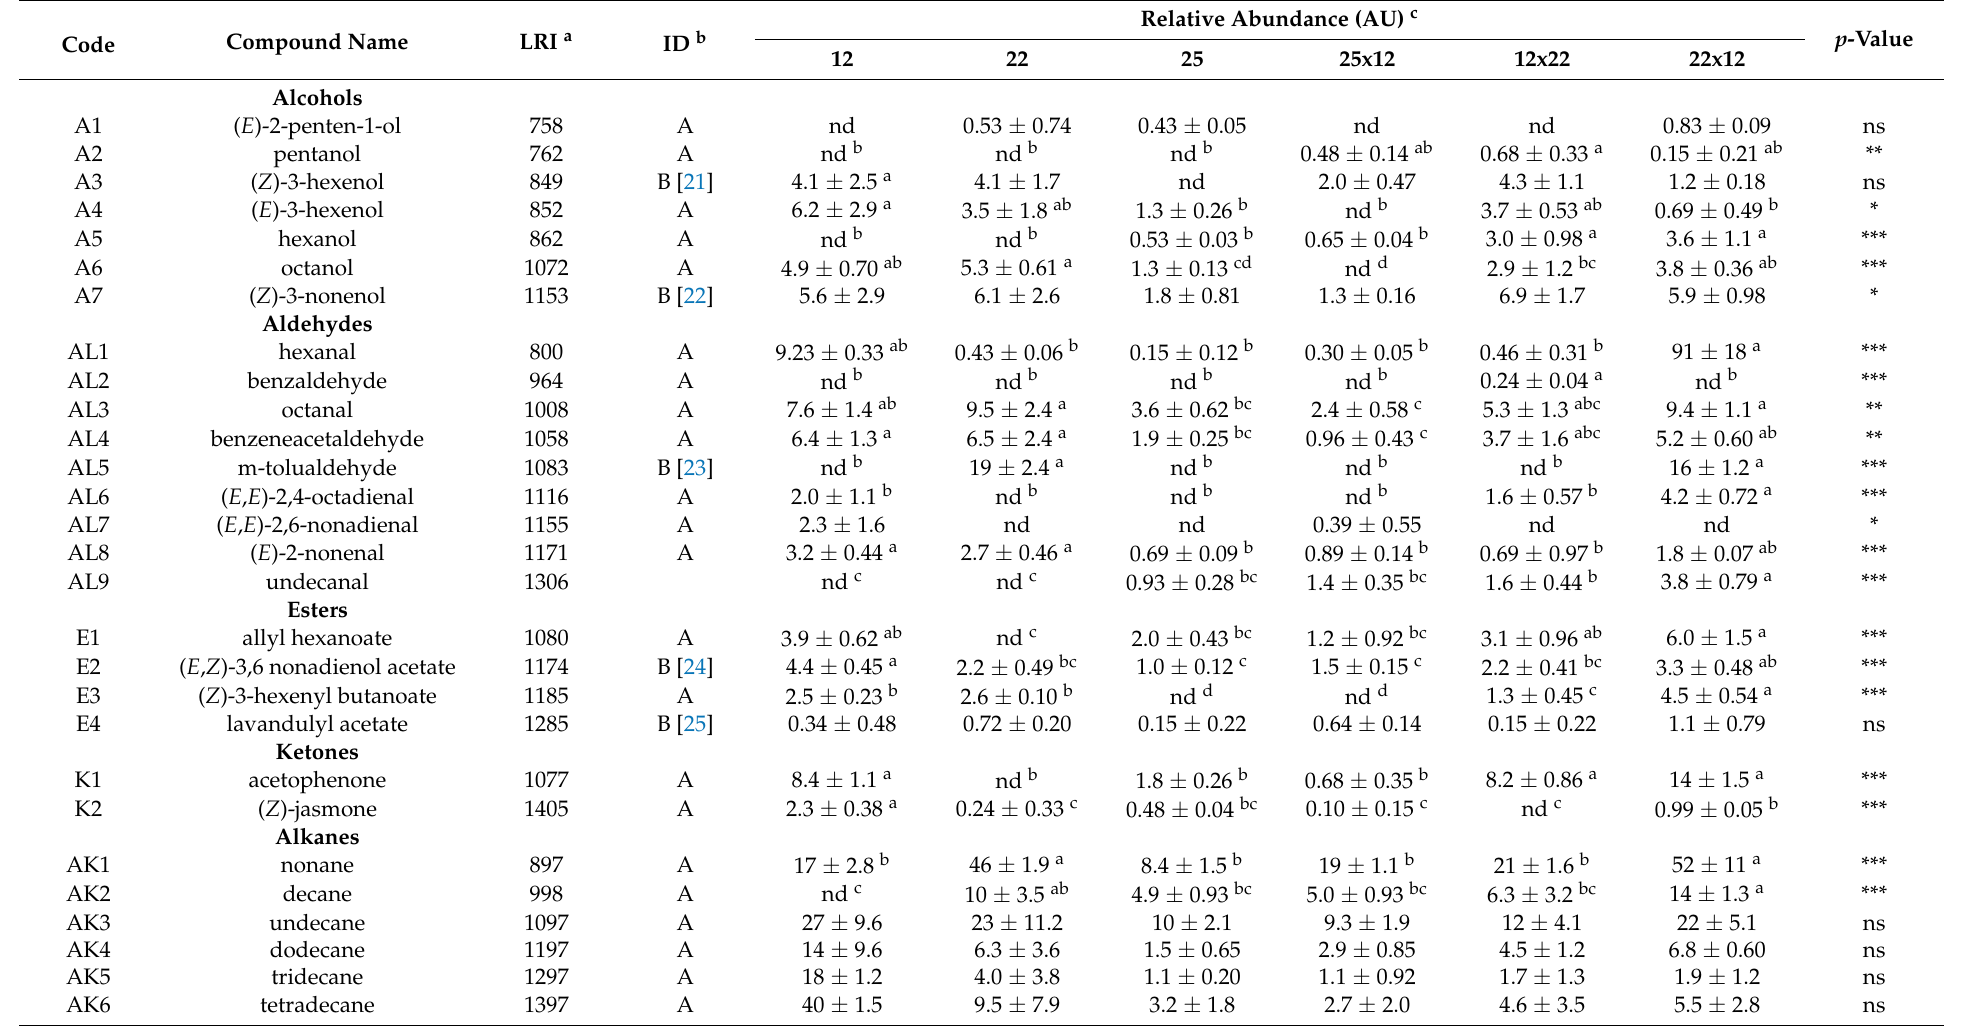
Table 1. Relative abundance of aroma compounds identified in the headspace of fresh celery